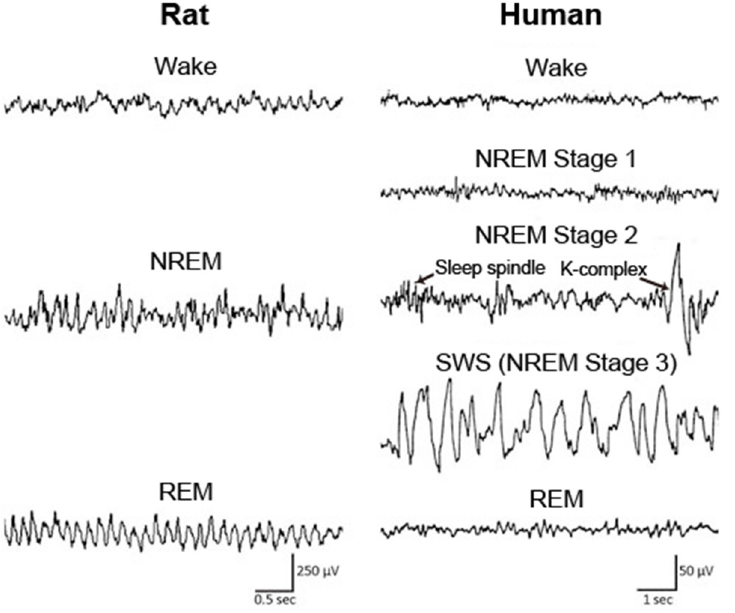
Figure 1. EEG across wake and sleep in human and rat. In rat, the sleep stage is classified into wake, NREM sleep, and REM sleep. In human, sleep is typically classified into NREM stage 1, NREM stage 2, NREM stage 3, and REM sleep according to the characteristics of EEG waveform, including sleep spindle and K-complex in NREM stage 2. NREM: non-rapid eye movement; REM: rapid eye movement; SWS: slow wave sleep. Figure adopted from [34] with permission.